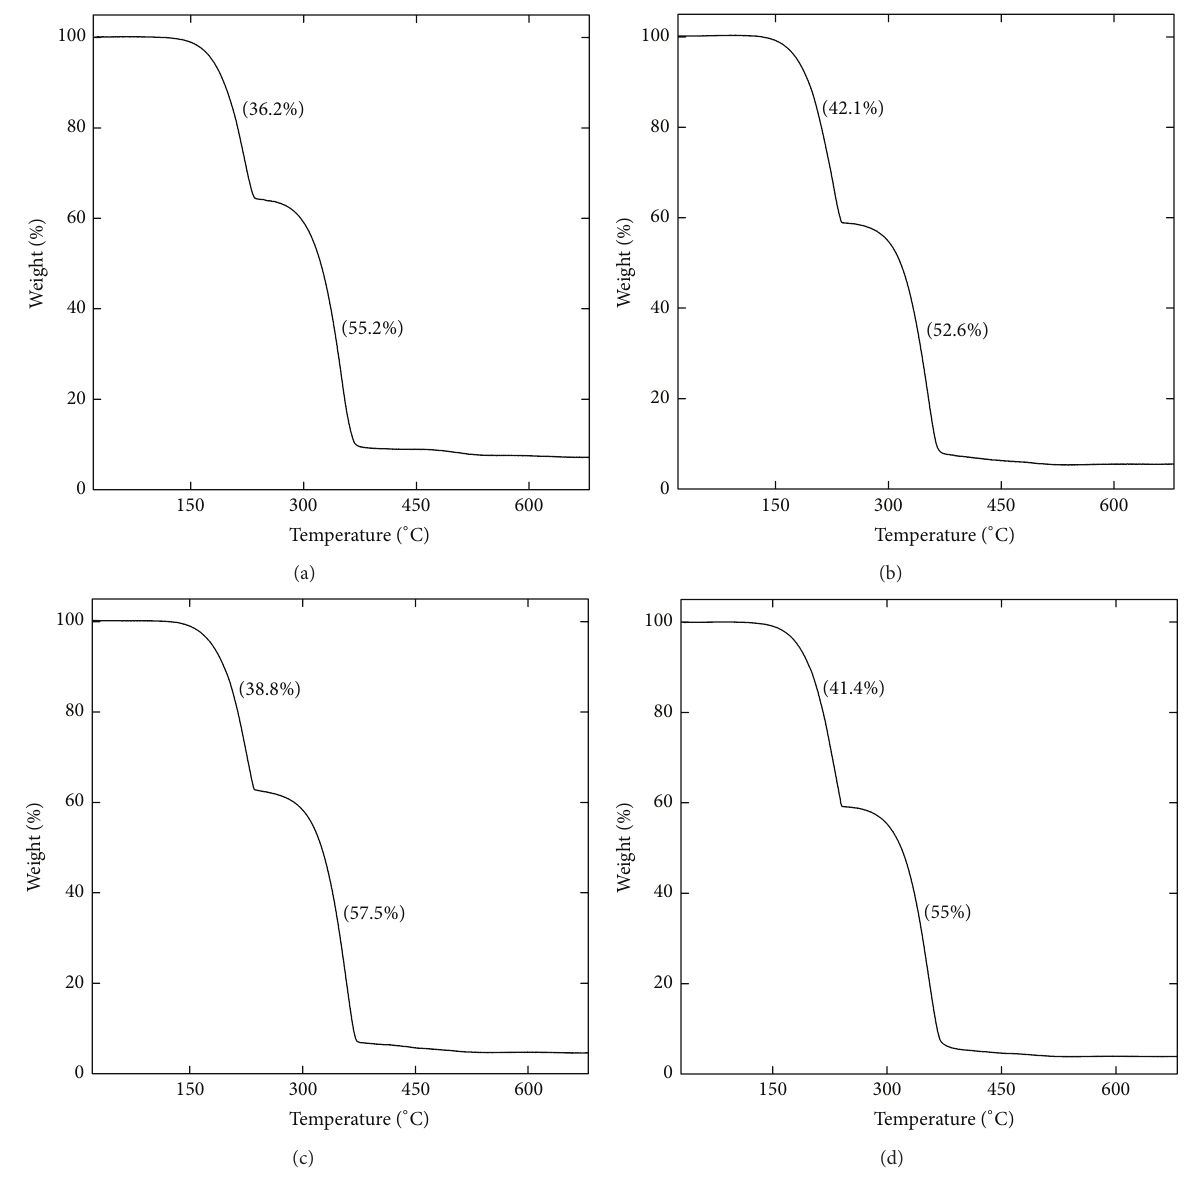
Figure 8: TGA curves of Zuota samples. (a) S1; (b) S2; (c) S3; (d)